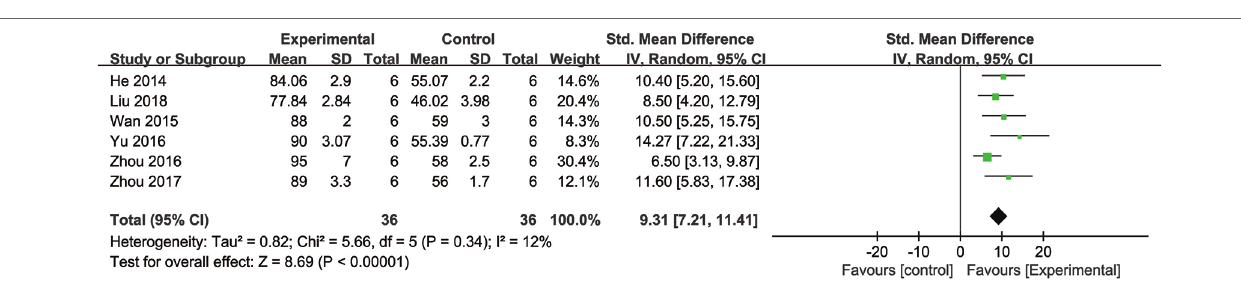
FIGURe 4 | The forest plot: effects of notoginsenoside R1 for increasing cardiomyocytes cell viability compared with the control group (n = 36 per group).